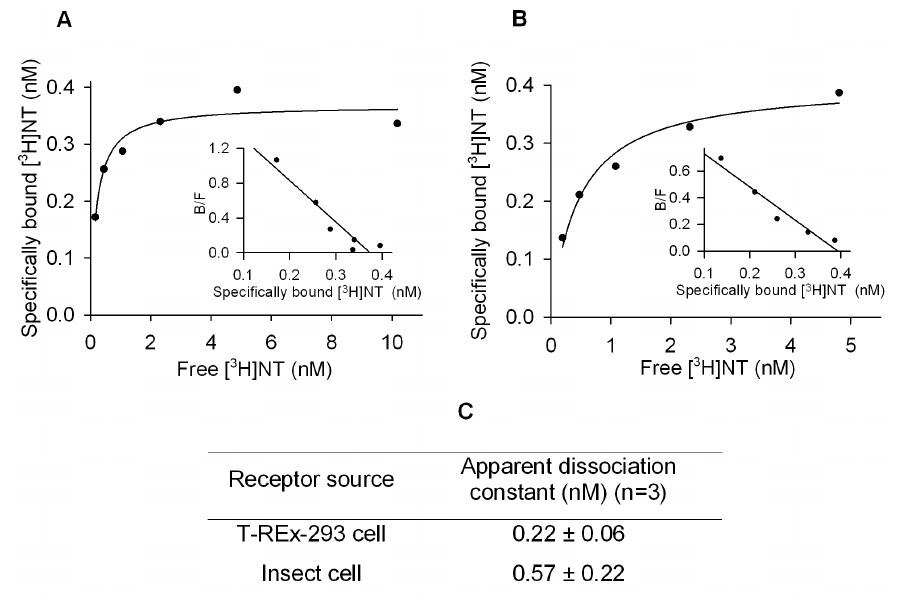
Figure 1. [ 3 H]NT saturation binding of NTS1 expressed in (A) T-REx-293 cells and (B) insect cells. NTS1 was extracted from membranes with the detergent DM/CHS and subjected to radio-ligand binding analysis. Inset: Scatchard transformation. Representative experiments conducted as single data points are shown. (C) Table summarizing the values of the apparent dissociation constants values for [ 3 H]NT binding. These values are not statistically different (P=0.2, unpaired two-tailed t-test). Data are collected from three repeated experiments.